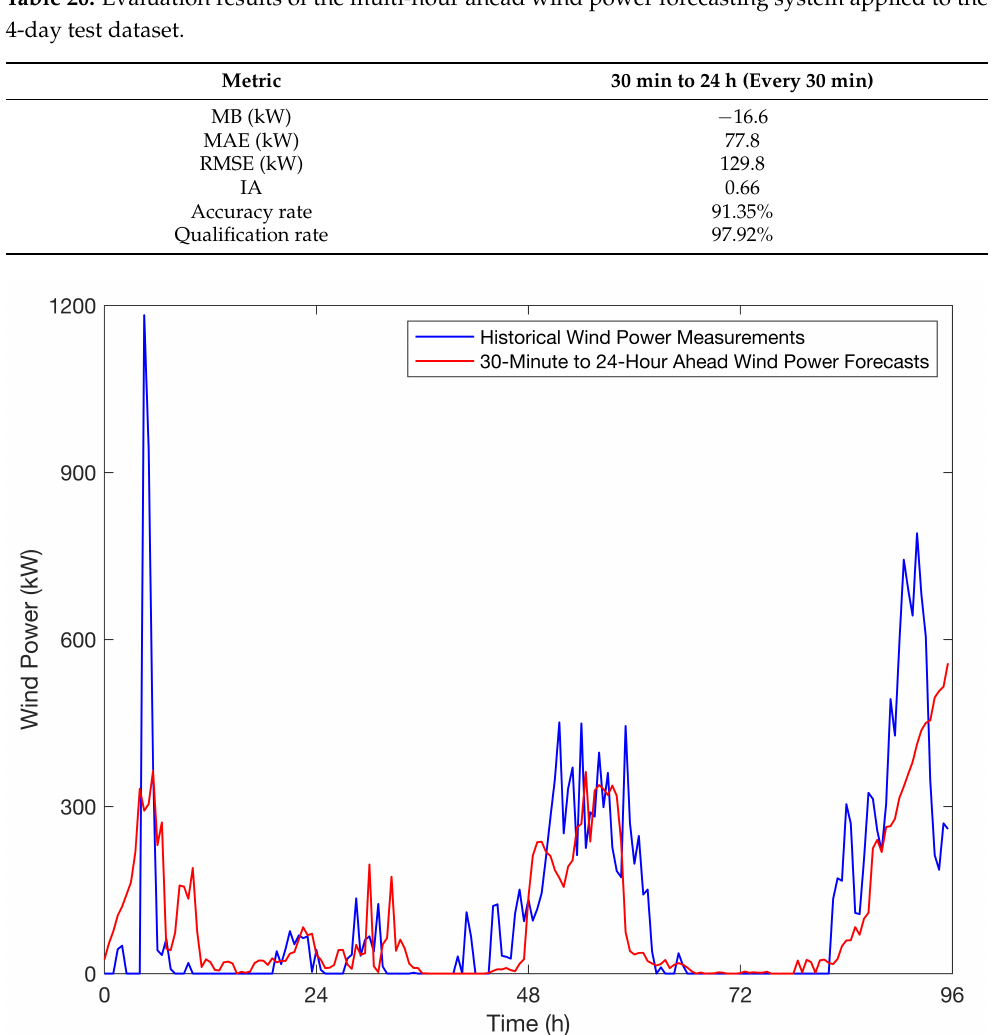
Figure 8. Comparison of the multi-hour ahead wind power forecasts provided by the proposed forecasting system and the historical wind power measurements from the 4-day test